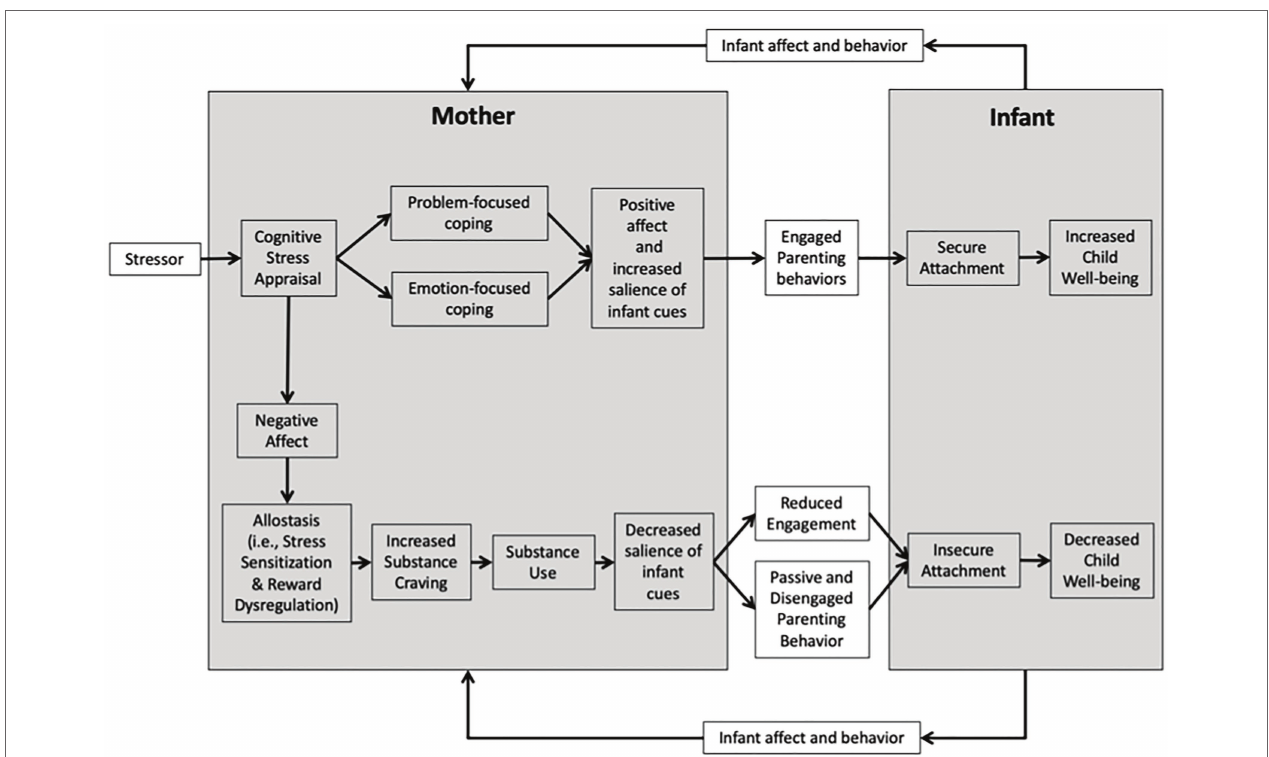
FIGURE 1 | Mechanisms of maternal substance use and child well-being model. This process model represents the connections between perinatal opioid use, parenting behaviors, and infant attachment development. As a mother encounters a stressor, her cognitive appraisal of the situation can drive adaptive coping, leading to positive affect, and engaged parenting behaviors. Alternatively, a negative cognitive appraisal may result in negative affect, promoting the process of allostasis—resulting in increased sensitivity to stress and dysregulation of reward processes. Allostatic load may lead to increased substance craving and substance use, which, over time, results in a decreased salience of infant cues, reduced engagement with the infant, and passive and disengaged parenting behavior. Gradually, the infant may develop an insecure attachment, being unable to rely on his mother’s response. Insecure attachment may then lead to an overall decrease in the child’s well-being. This model also highlights the process of dyadic synchrony. The infant’s affect and behavior also influence the mother’s affect and behavior. As the child learns that the mother’s behavior is unreliable, she may reach out to her mother through behavior that can be interpreted as stressful by her mother, which may reinforce her mother’s cycle of substance craving and